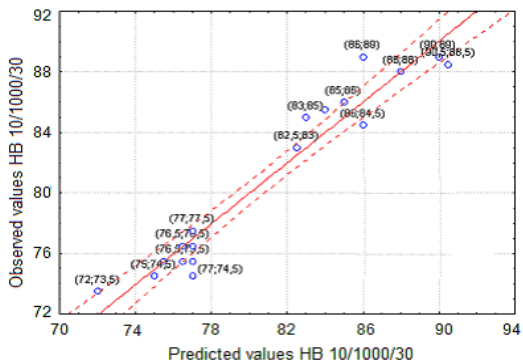
Fig. 5. Effect of change of values of characteristic points: a) t and b) U